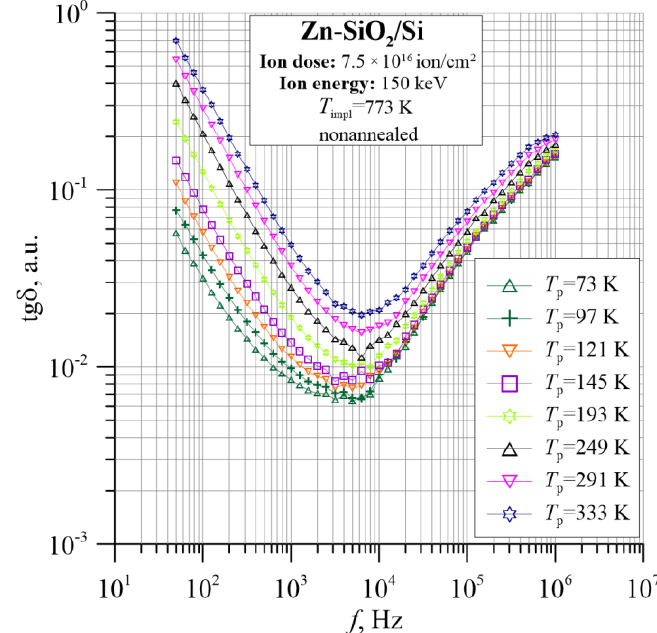
Figure 7. Temperature dependence of the tangent of dielectric loss angle tg δ for the Zn-SiO 2 /Si nanocomposite immediately after preparation under “hot” implantation conditions (150 keV, 7.5 × 10 16 ion/cm 2 , T impl = 773 K).